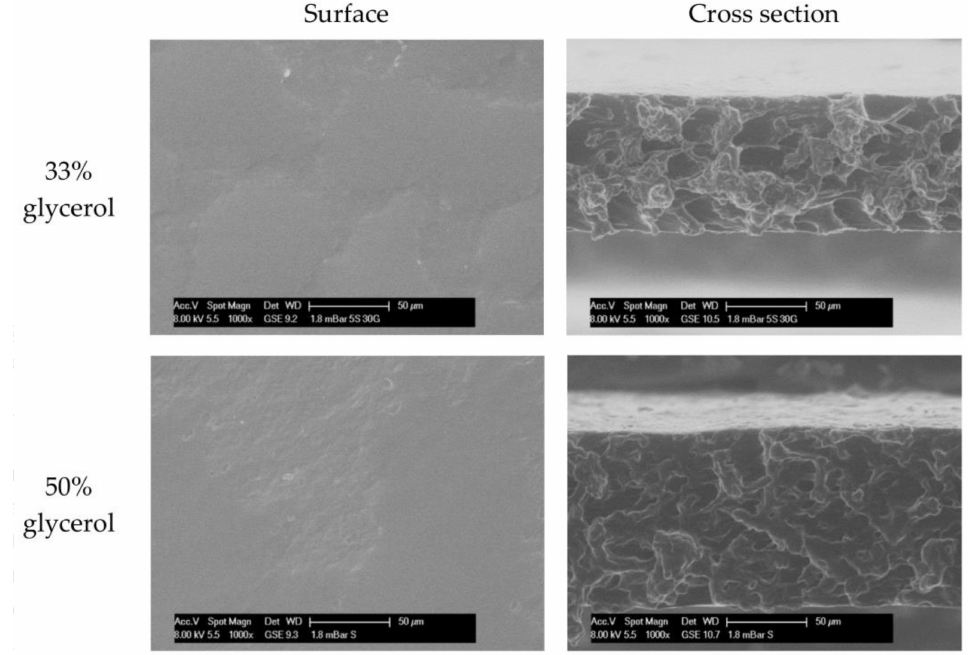
Figure 3. ESEM micrographs of surface exposed to air during drying and cross section of starch-based films containing 33% or 50% glycerol ( w / w ) at a magnification of ×